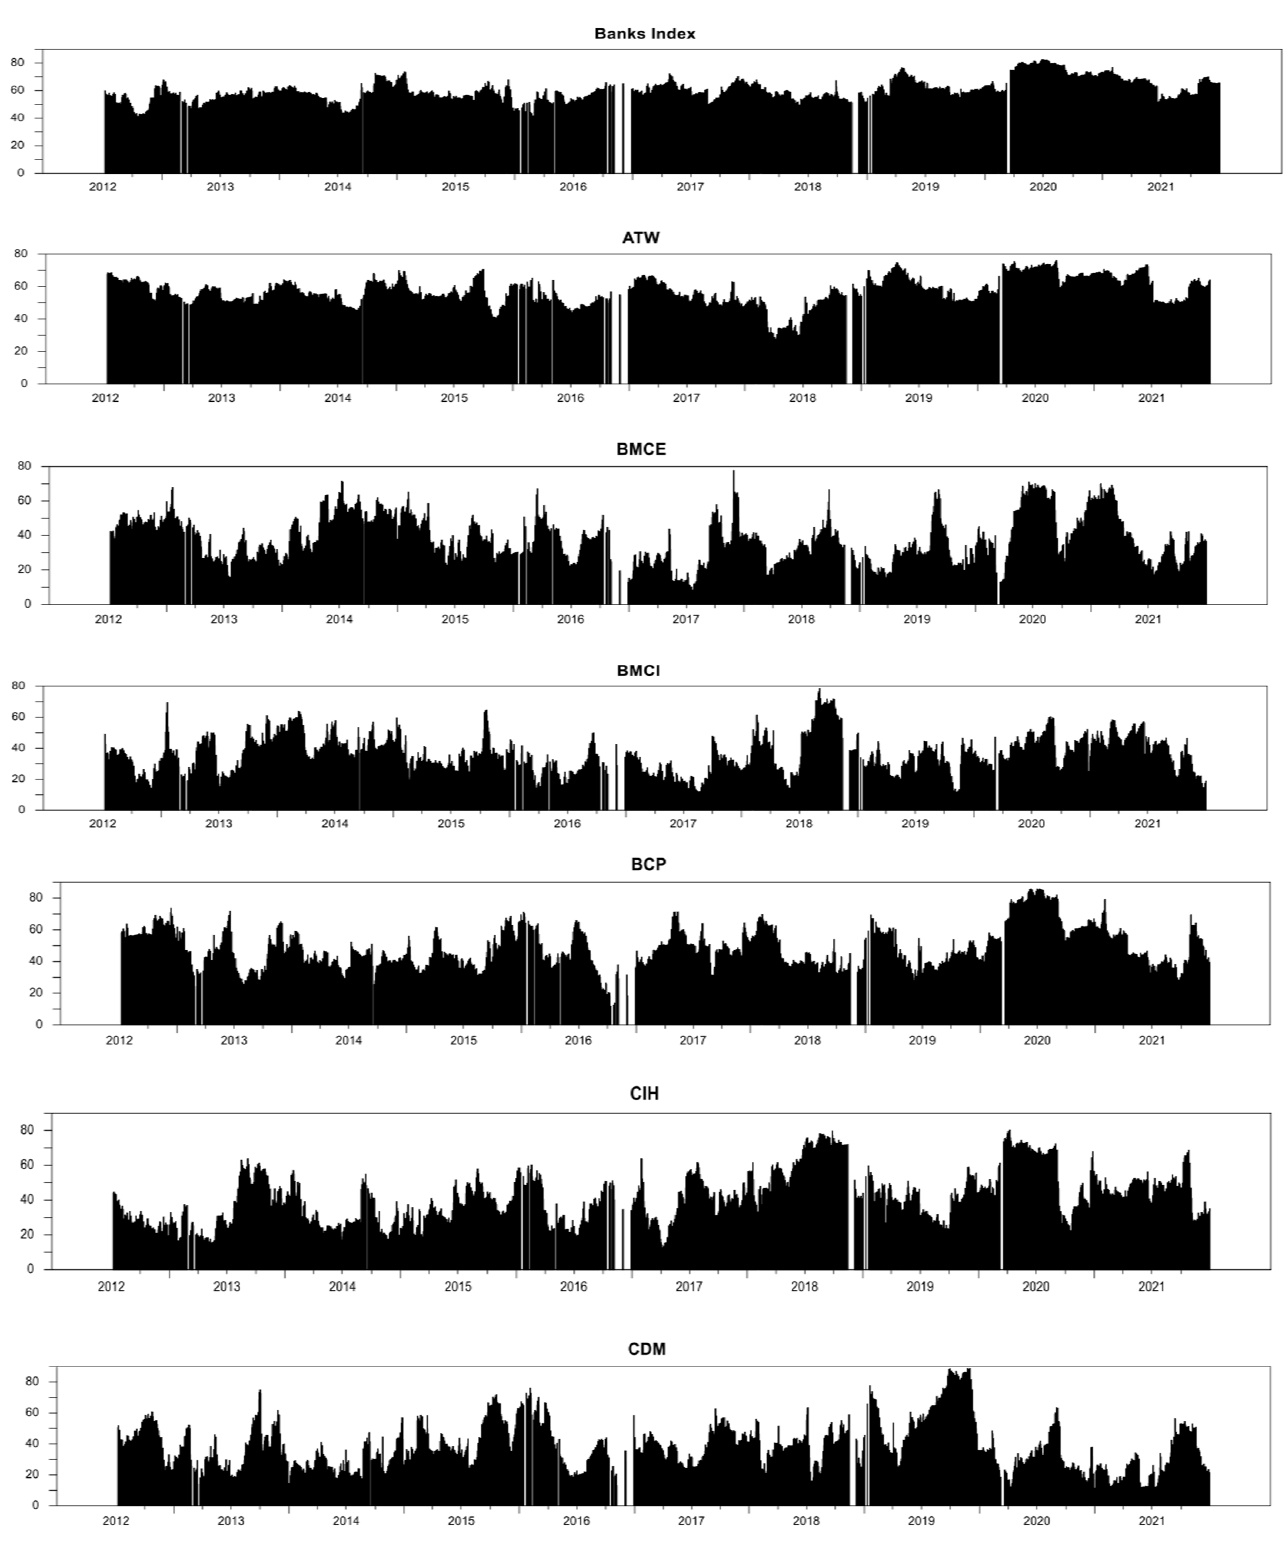
Figure 7. Directional Volatility Spillovers FROM others.